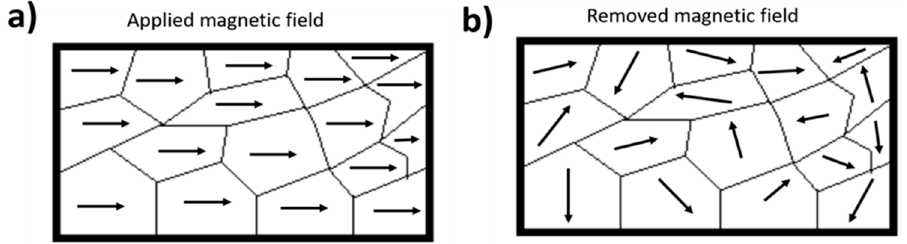
Figure 2. Magnetic behavior in function of magnetic field. ( a ) Superparamagnetic nanomaterial aligns in a similar manner in the direction of the external magnetic field. ( b ) Magnetic moment of the particles returns to its initial orientation.